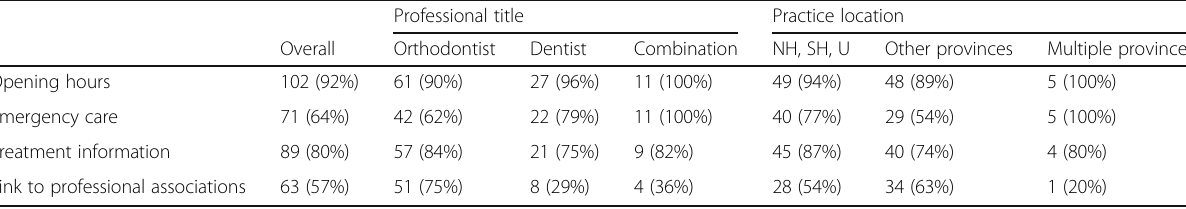
Table 2 Reporting of discretionary information items by the examined websites according to CED guidelines (in parentheses, the respective